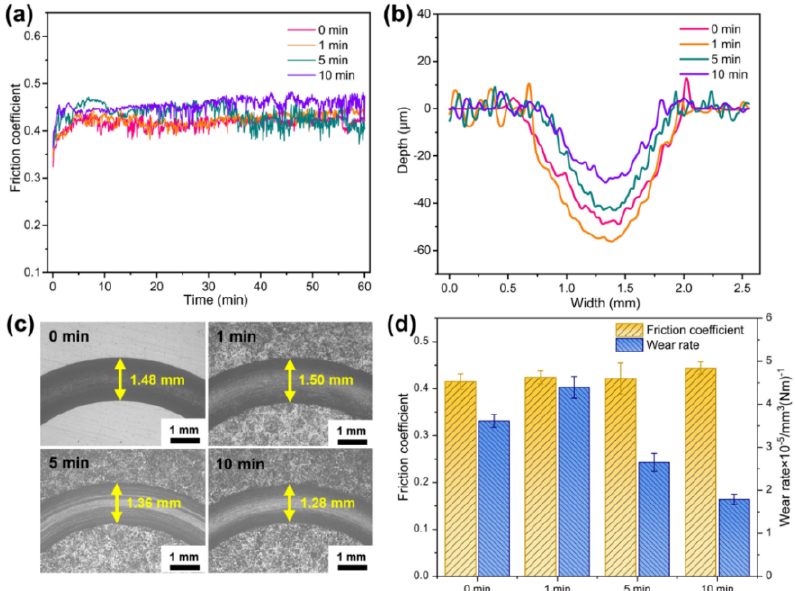
Figure 10. ( a ) Friction coefficient as a function of wear time; ( b ) section profile of the wear track; ( c ) width of wear track; ( d ) average friction coefficients and wear rates of the M50 steel with different USP durations.